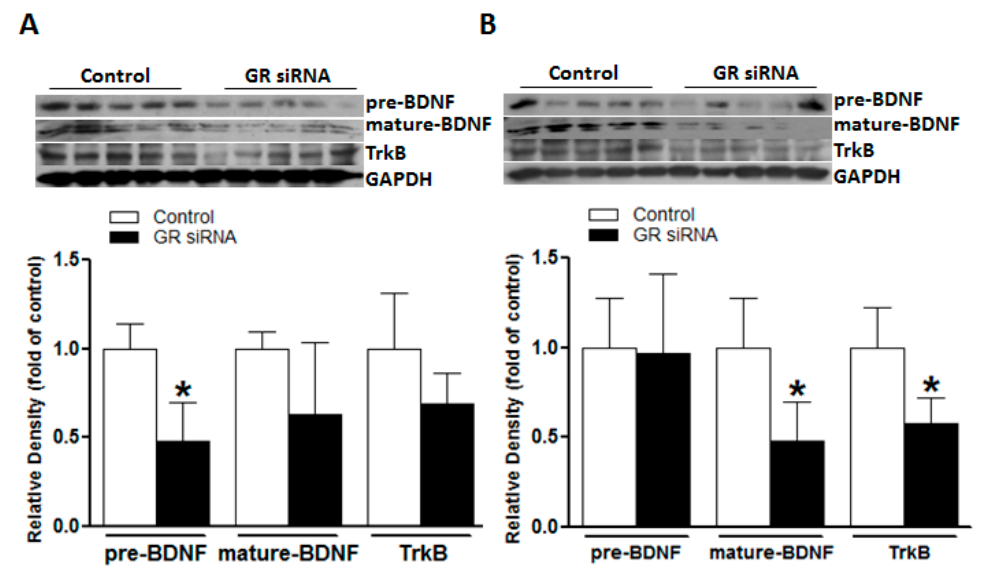
Figure 4. The GR repression inhibited brain-derived neurotrophic factor/tropomyosin receptor kinase B (BDNF/TrkB) signaling in mice brains. The mice received either GR siRNA (100 pmol) or its negative control (Neg. Control; 100 pmol) via intracerebroventricular (i.c.v.) injection. The brain samples were collected at 24 h and 48 h after i.c.v. treatment. The brain-derived neurotrophic factor (BDNF; pre- and mature-BDNF) and Tropomyosin receptor kinase B (TrkB) were determined via western blotting at 24 h ( A ) and 48 h ( B ), respectively. n = 5. * p < 0.05, GR siRNA vs. Control.